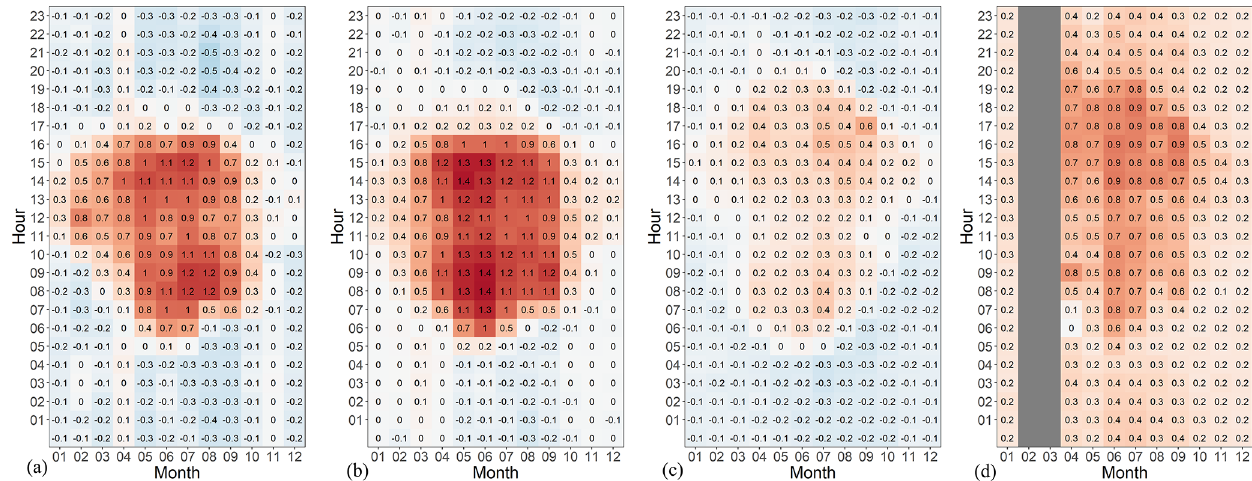
Figure 10. Temperature difference ( (cid:49)T = T LC-R − T AWS ) as a function of hour of the day and month of the year for each reference station, (a) LC-R01, (b) LC-R02, (c) LC-R04 and (d) LC-R05, at QC level 1. Background colours, ranging from blue ( − 1.7 ◦ C) to red (1.7 ◦ C), represent the (cid:49)T . The temperature difference was calculated for all measurements between the installation date of each LC-R and December